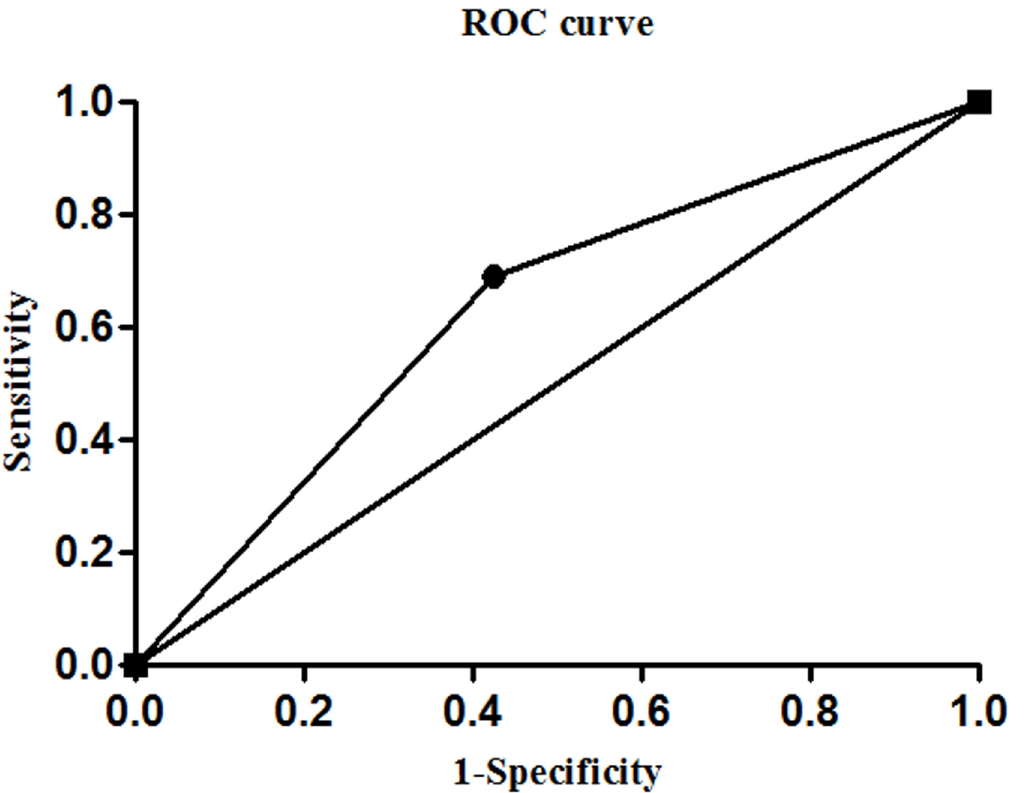
Fig 3. Combined detection of Zic1 promoter methylation and the CEA level (parallel testing) in gastric cancer (GC) plasma specimens. An ROC curve for evaluating the significance of the combined detection of the two parameters for GC diagnosis.